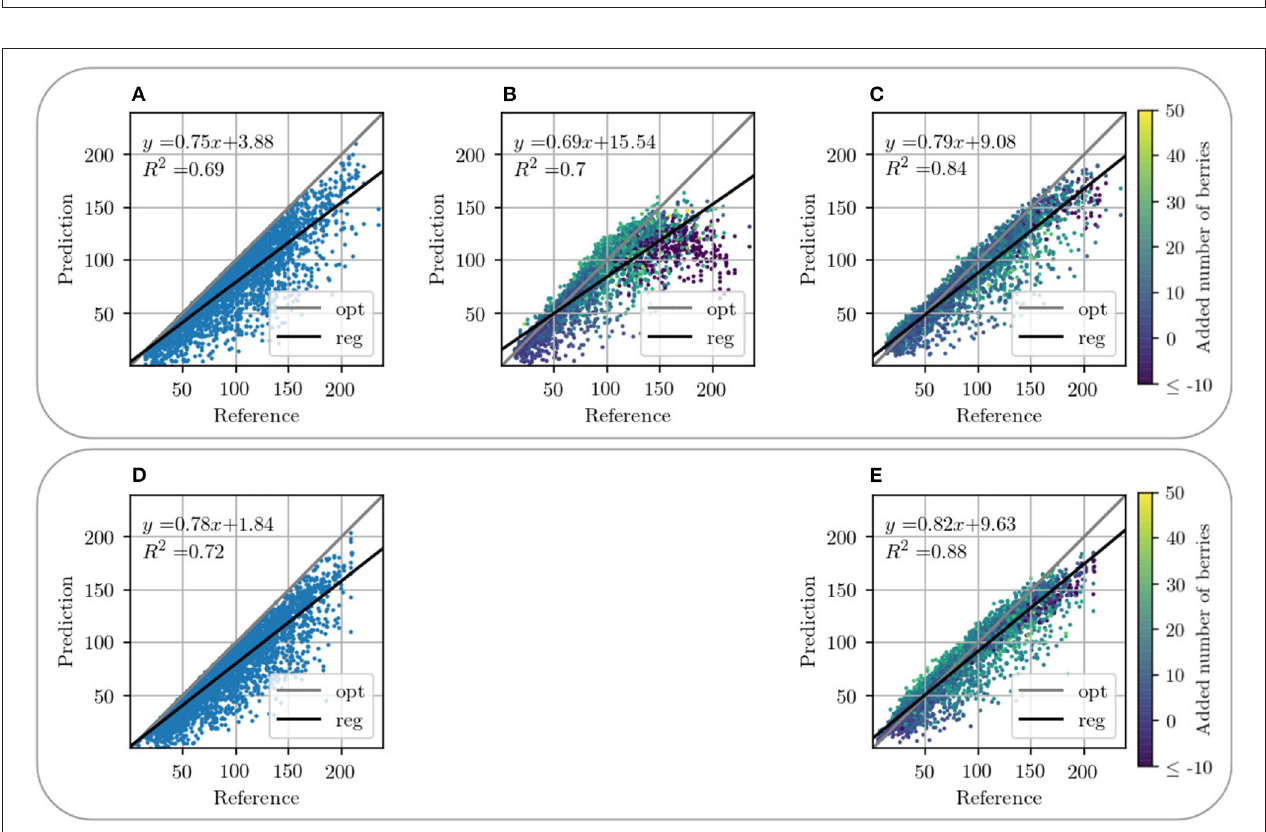
FIGURE 9 | Mask-based comparison of GB and B data with respect to (A) the correlation between input patch x occ and generated input patch domain, and (B) the correlation between target output x non and generated output assigned to a specific range of correlation. One bar corresponds to the range of 0.01.